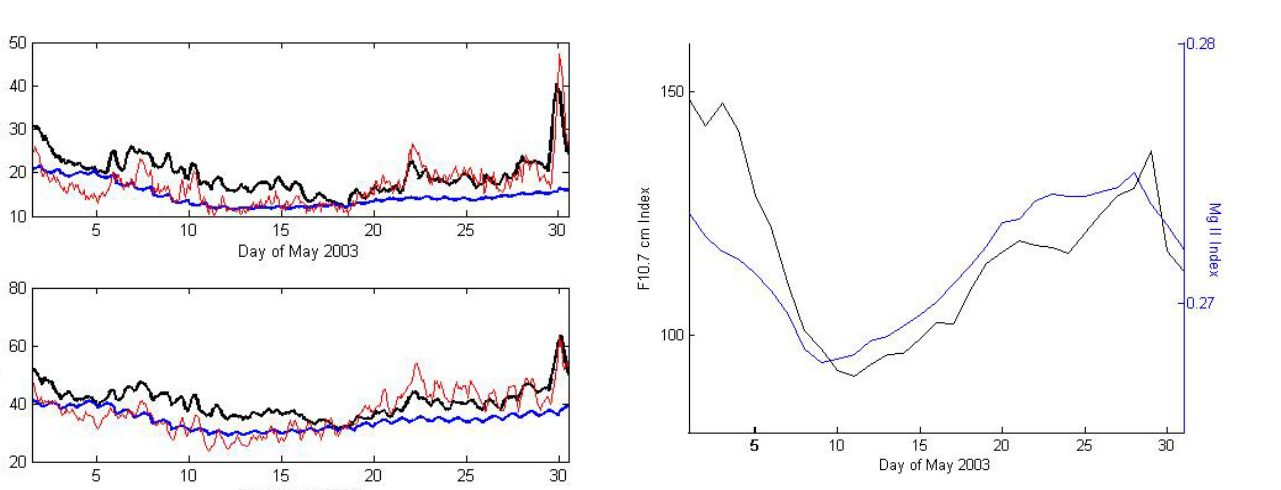
Fig. 6. Variations with UT of the F10.7 Solar index (black line) and the composite Mg II index described in Viereck et al. (2004) (blue